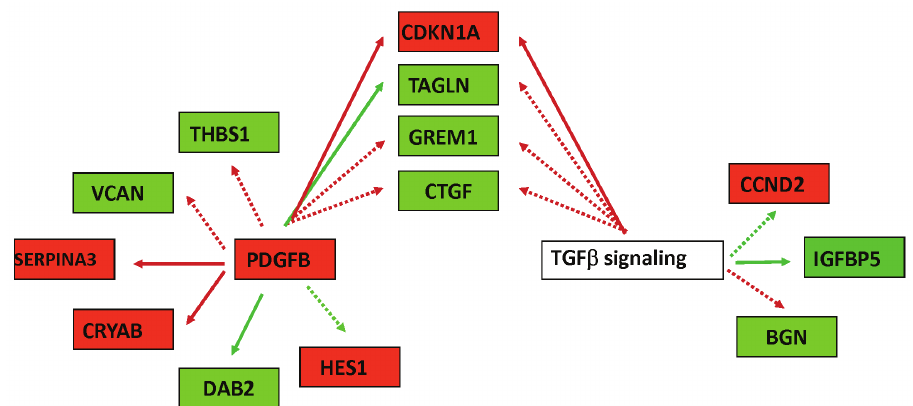
Figure S4. Schematic depiction of PDGFB and TGF β expression edges according to IPA and comparison with the actual behavior of first degree nodes in response to NKX3.1 expression in LH cells. Green color indicates upregulation, whereas red color signifies downregulation. The arrows represent the expression edges. Solid arrows indicate agreement between observed expression behavior and the behavior expected in response to activation of PDFGB or TGF β according to the information contained in the IPA database. The stippled arrows indicate disagreement. Example: PDGF is expected to upregulate HES1. Induction of PDGF by NKX3.1 is therefore consistent with the change in HES1 mRNA (edge is solid red arrow). PDGFB is also expected to upregulate THBS1 (red edge), but NKX3.1 expression leads to suppression of THBS1. Hence the edge is a stippled arrow.